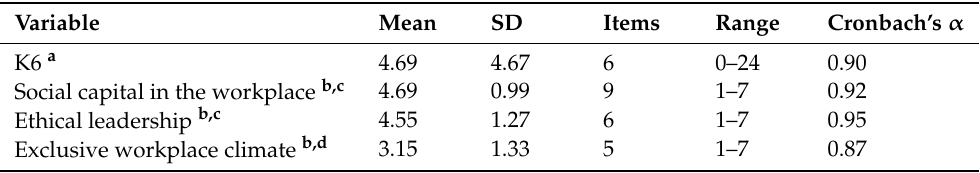
Table 2. Descriptive statistics and reliability of each scale and the association between dependent variables ( n =